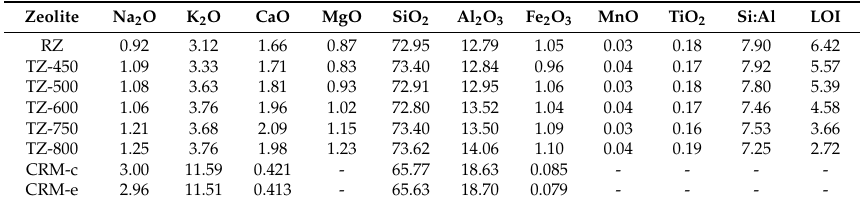
Table 1. Chemical compositions (wt.%) of the raw zeolite (RZ) and zeolites thermally treated at 450 ◦ C